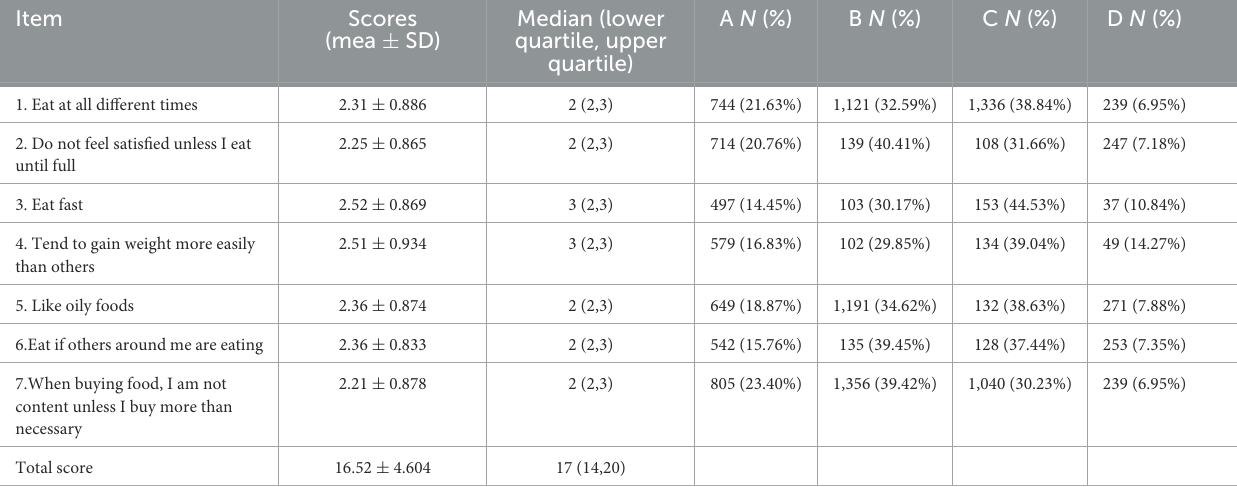
TABLE 2 Scores of each item in the EBS short form.